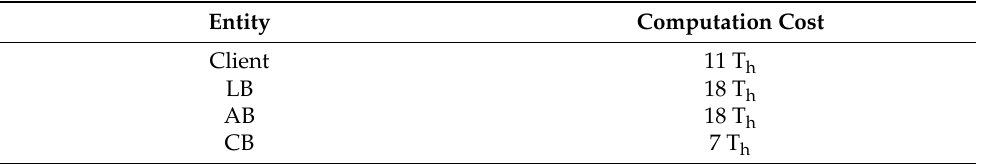
Table 4. Computation cost for the client, LB, AB, and